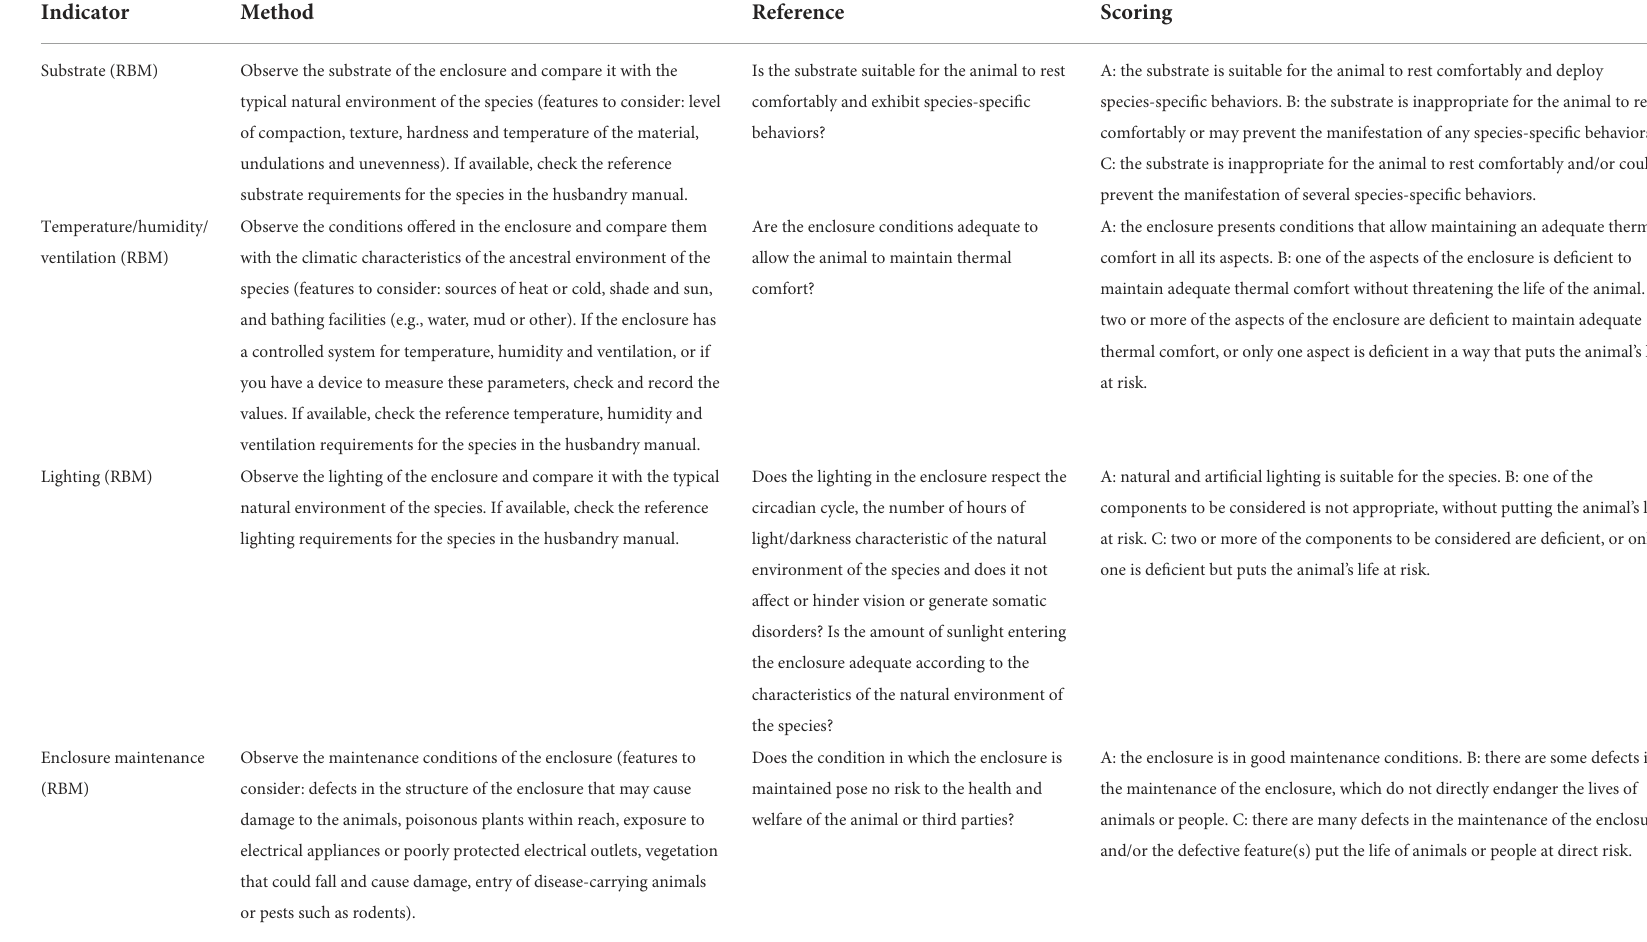
TABLE 6 Summary of the information provided in the user’s manual for assessing environmental domain.